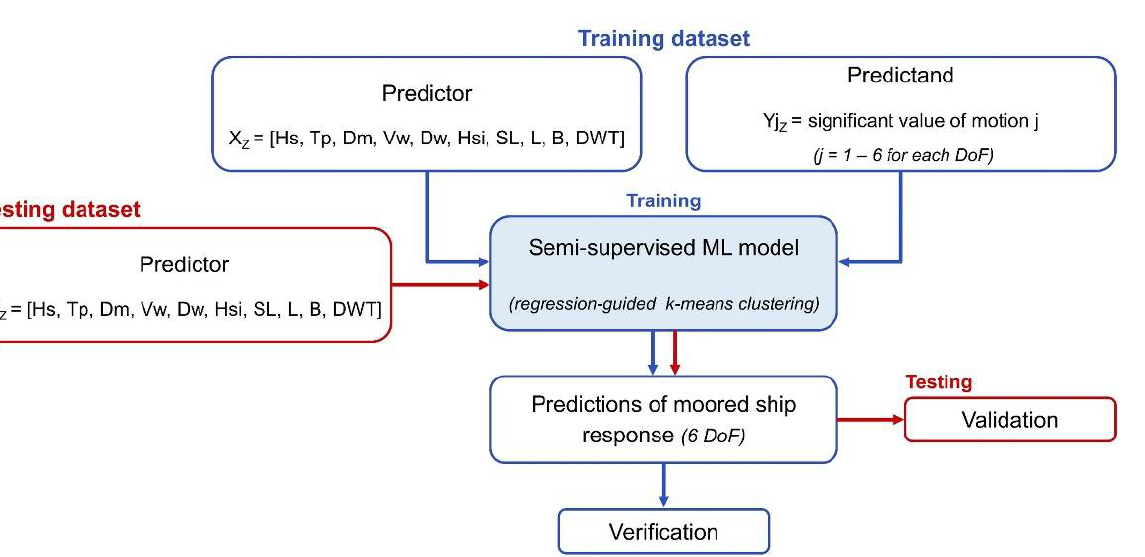
Table 2. Size of data samples used for training and testing the prediction model including infra- gravity wave information in the input dataset. Number of the available hourly subsets for each type of motion. Percentage (%) of data, with respect to the whole dataset, used for training and testing.